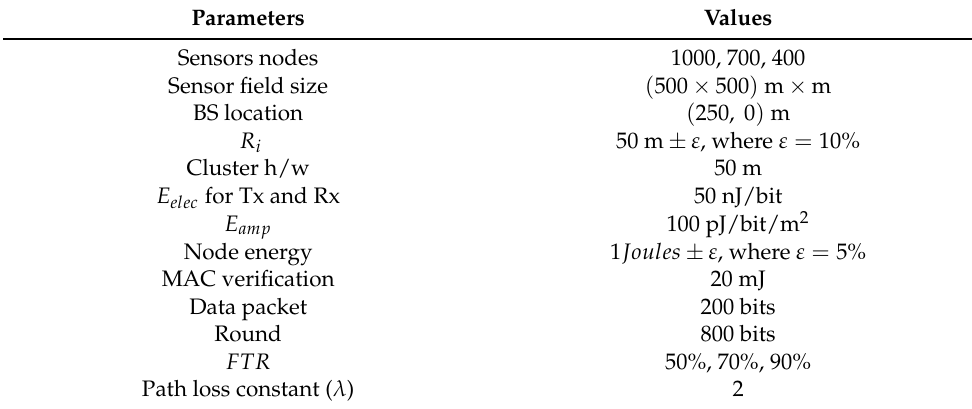
Table 2. Experimental parameters for Performance Evaluations.